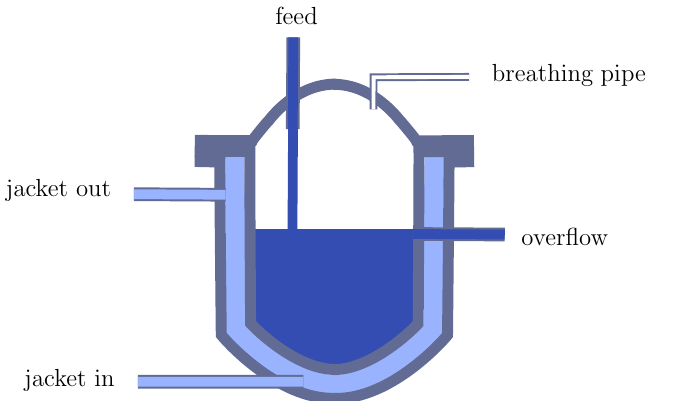
Figure 7. The configuration of a jacket tank with an inflow, an overflow and a breathing pipe for pressure compensation.